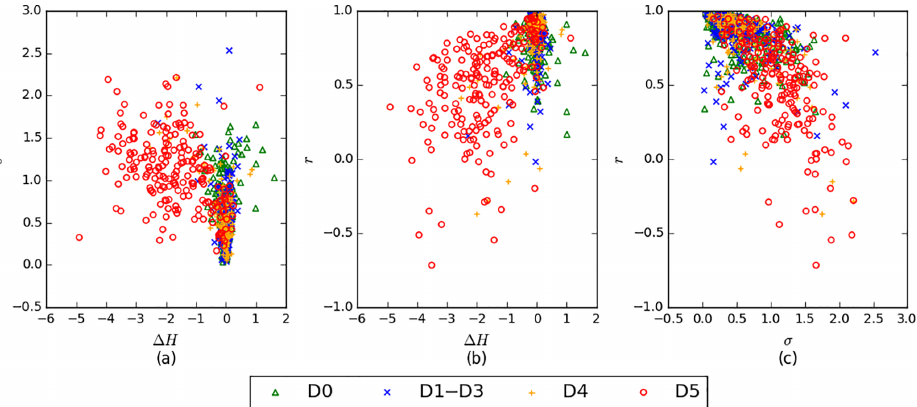
Figure 6. Scatter plots of the three parameters ( (cid:49)H , σ , r) calculated from the lidar DSMs for the buildings surveyed by Yamada et al.